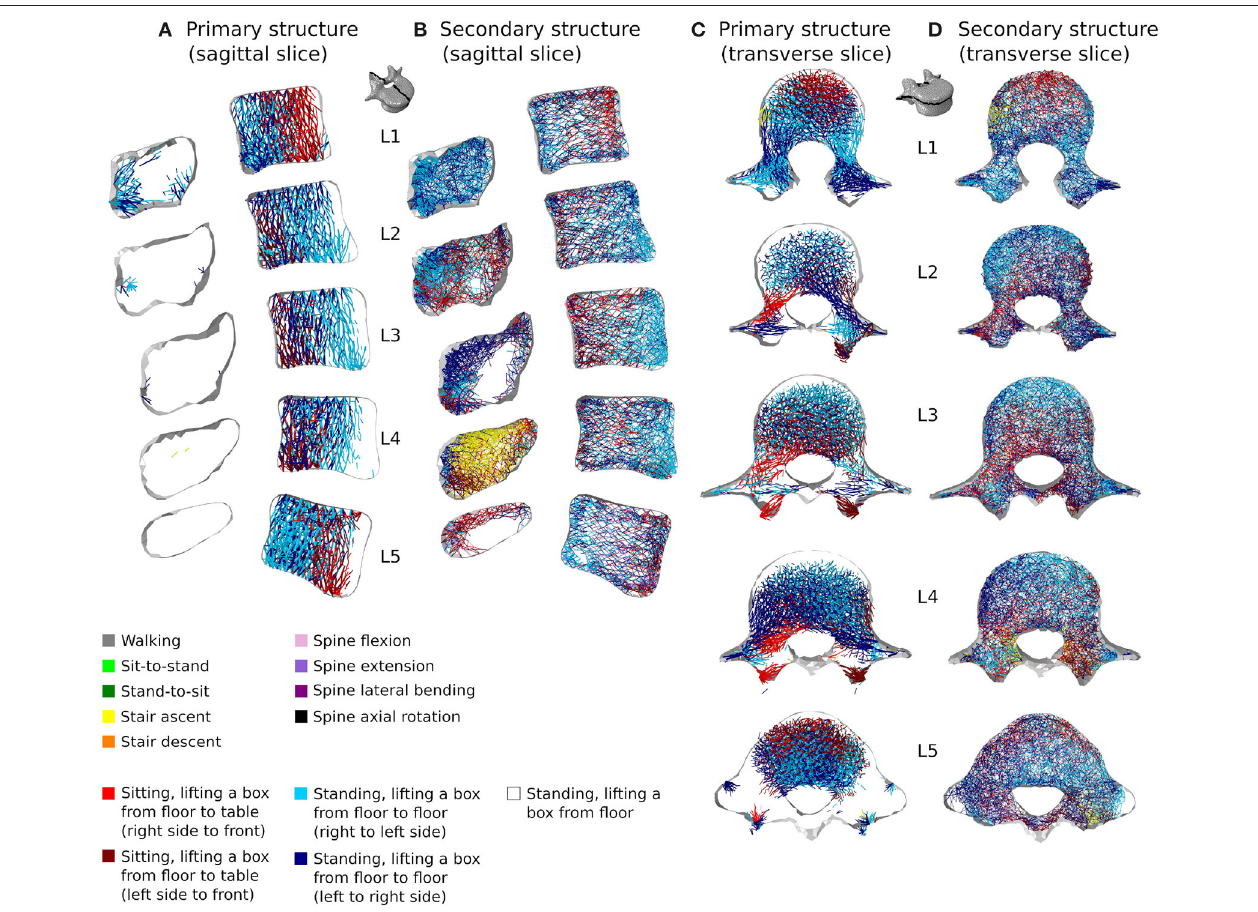
FIGURE 10 | 3 mm mid-sagittal (XY plane) and through-processes transverse (XZ plane) slices of the converged models in the healthy scenario, showing a map of which activity gives rise to the highest absolute maximum axial strain for the adaptation of the trabecular truss elements of the primary (A,C) and secondary (B,D) structures. Cortical shell elements are shown in light